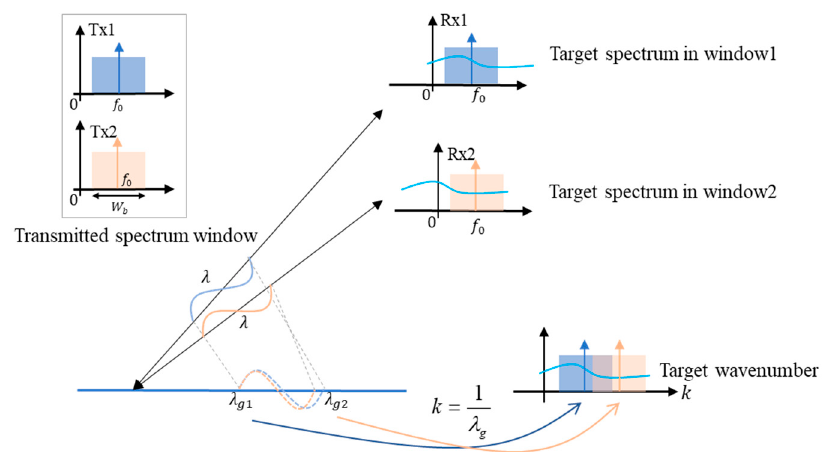
Figure 7. Schematic diagram of the principle of baseline decorrelation.